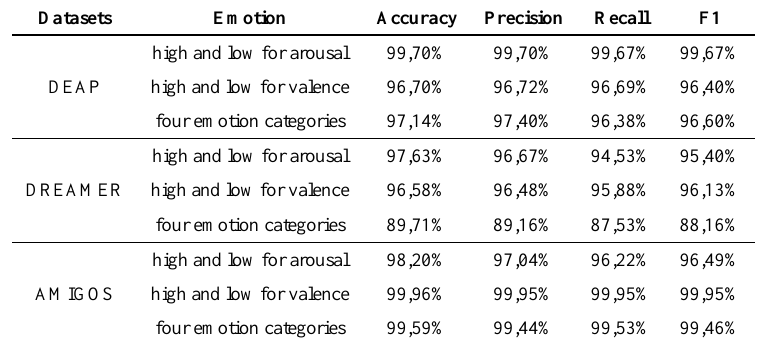
Table 11. Accuracy, precision, recall, and F1 values of the proposed method in Present